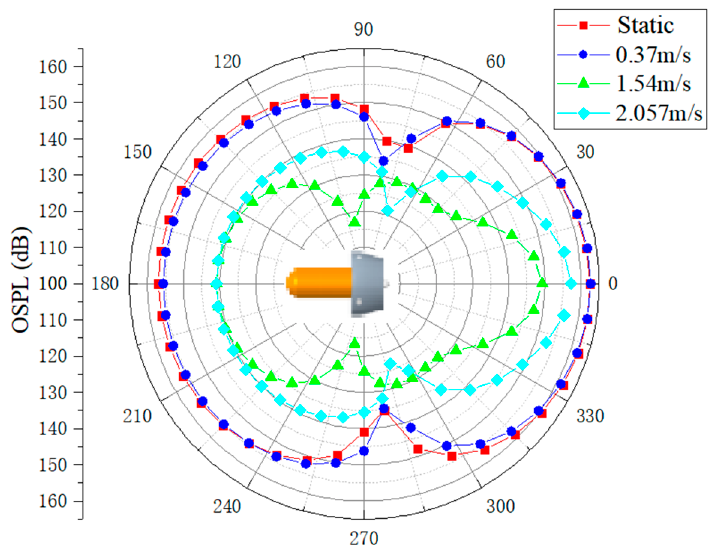
Figure 16. Directivity diagram of total sound pressure level at different navigational speeds.